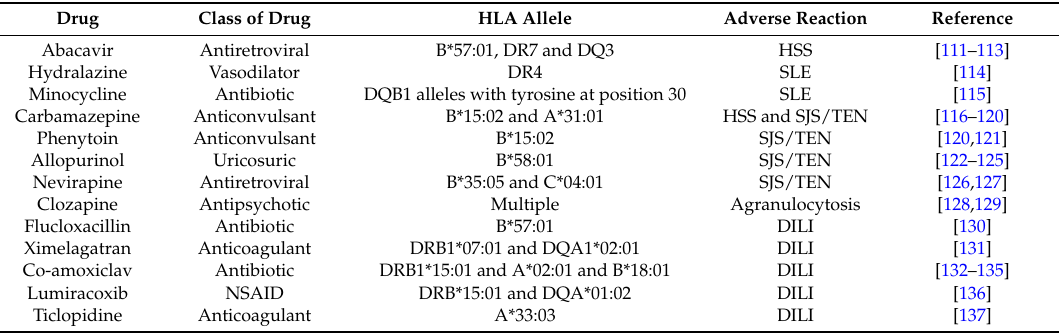
Table 4. Pharmacogenetics of immune-mediated adverse drug reactions. NSAID = non-steroidal anti-inflammatory drug; HSS = Hypersensitivity syndrome; SJS = Stevens–Johnson syndrome; TEN = toxic epidermal necrolysis; DILI = Drug-induced liver injury. Drug Class of Drug HLA Allele Adverse